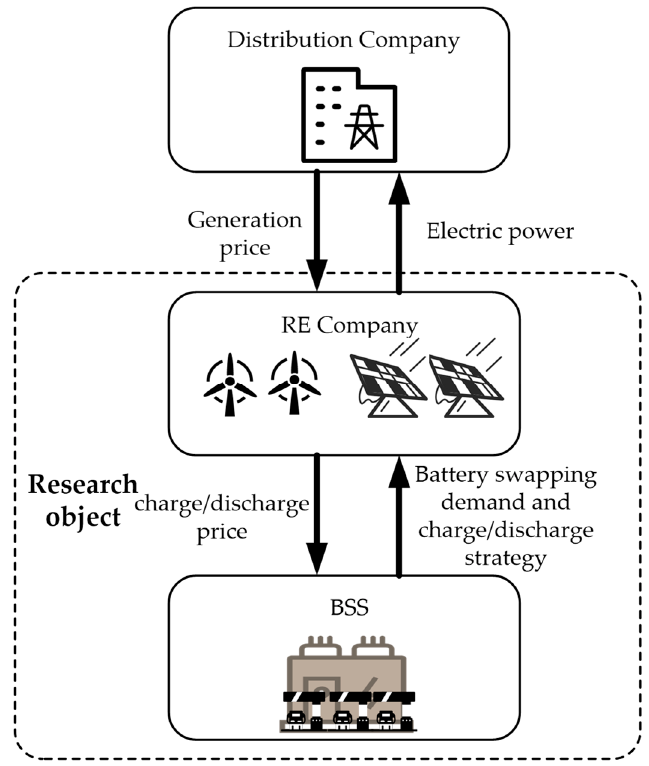
Figure 1. Block diagram of cooperation between renewable energy (RE) company and battery switch station (BSS).